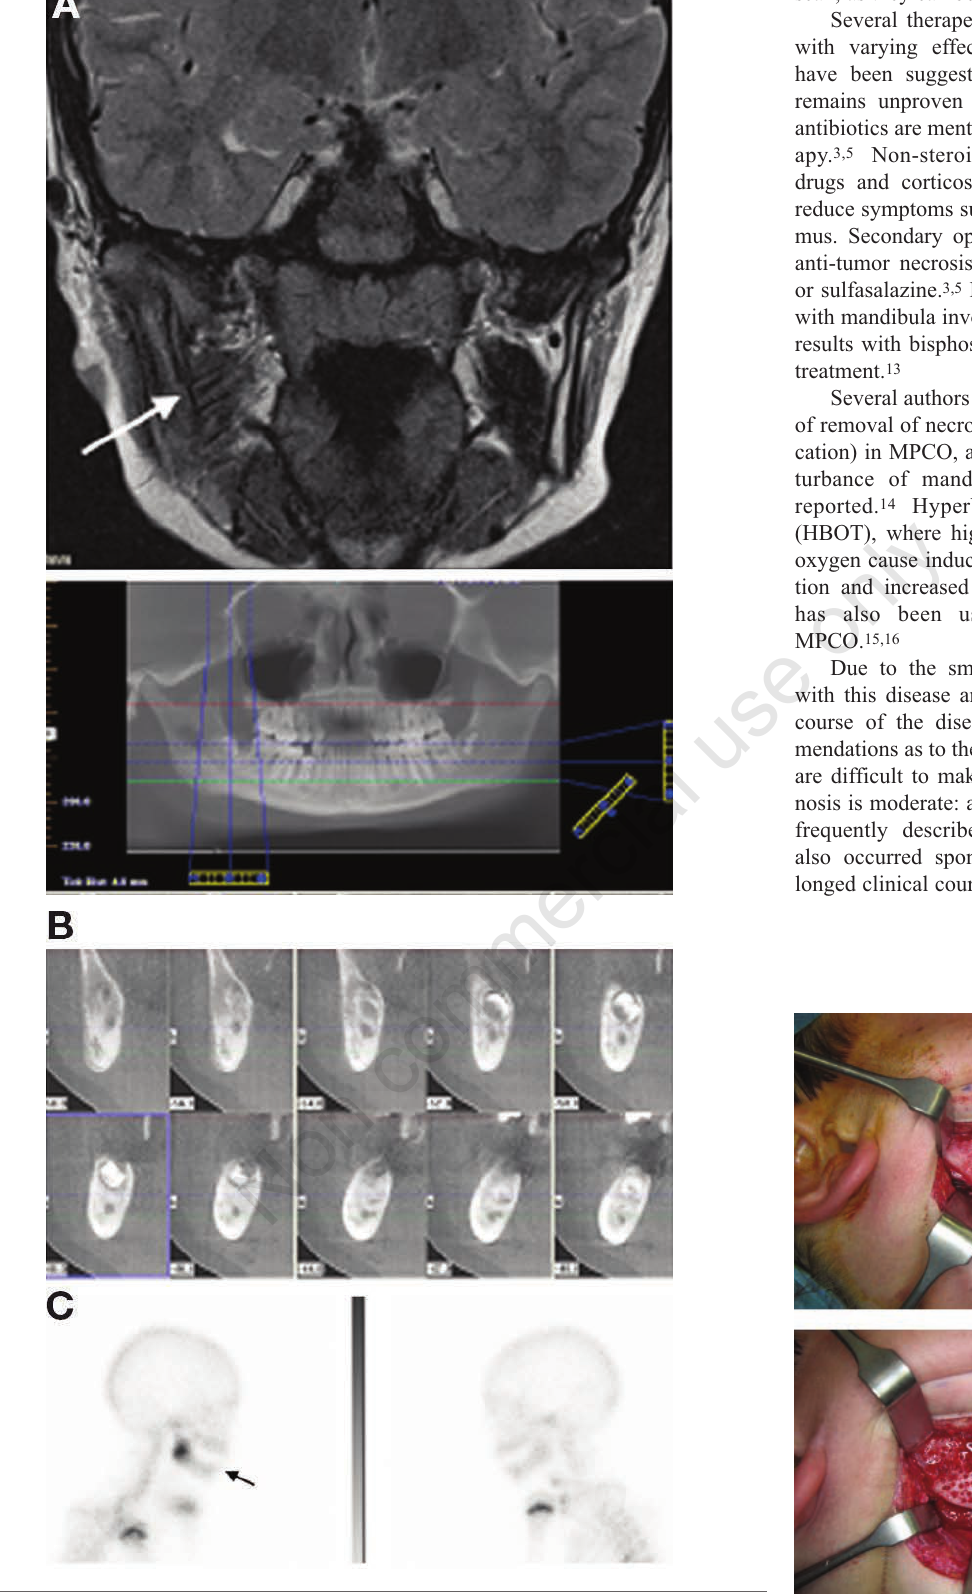
Figure 2. Investigations of the jaw: A) Magnetic Resonance Imaging (MRI) performed two years after start of symptoms. The white arrow indicates where the right mandible is diffusely broadened, with several areas of interruption of the cortex and soft tissue swelling. B) Technetium (TC) scan. C) Bone scintigraphy of the patient shows a signifi- cant enhancement of the right side of the mandible (black